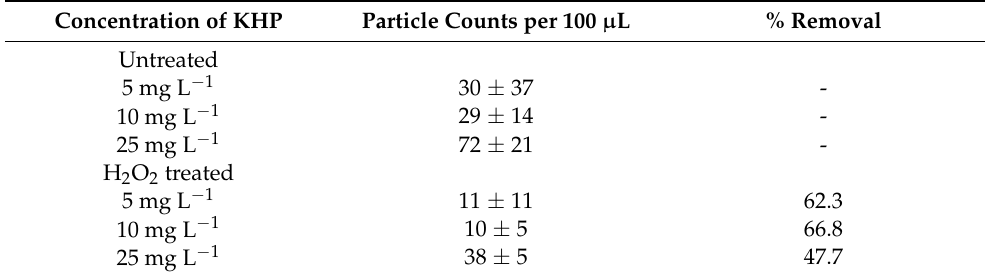
Table 2. Organic carbon removal efficiencies by H 2 O 2 wet oxidation. Concentration of KHP Particle Counts per 100 µ